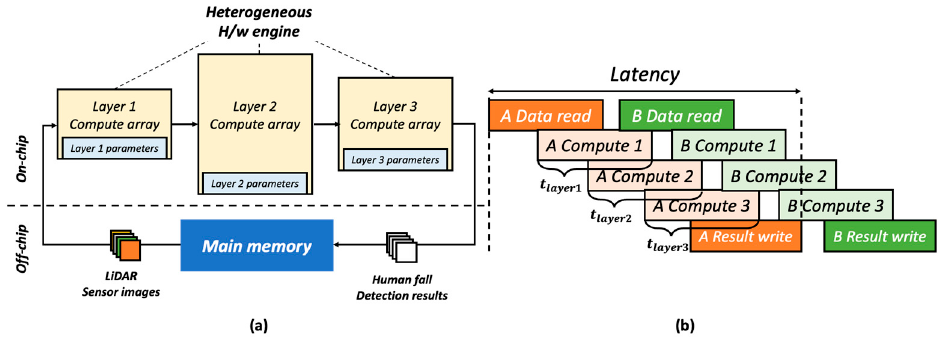
Figure 12. Heterogeneous streaming architecture ( a ) Layer-dedicated H/W engine, ( b ) Pipelined streaming architecture. Table 2. PE and SIMD